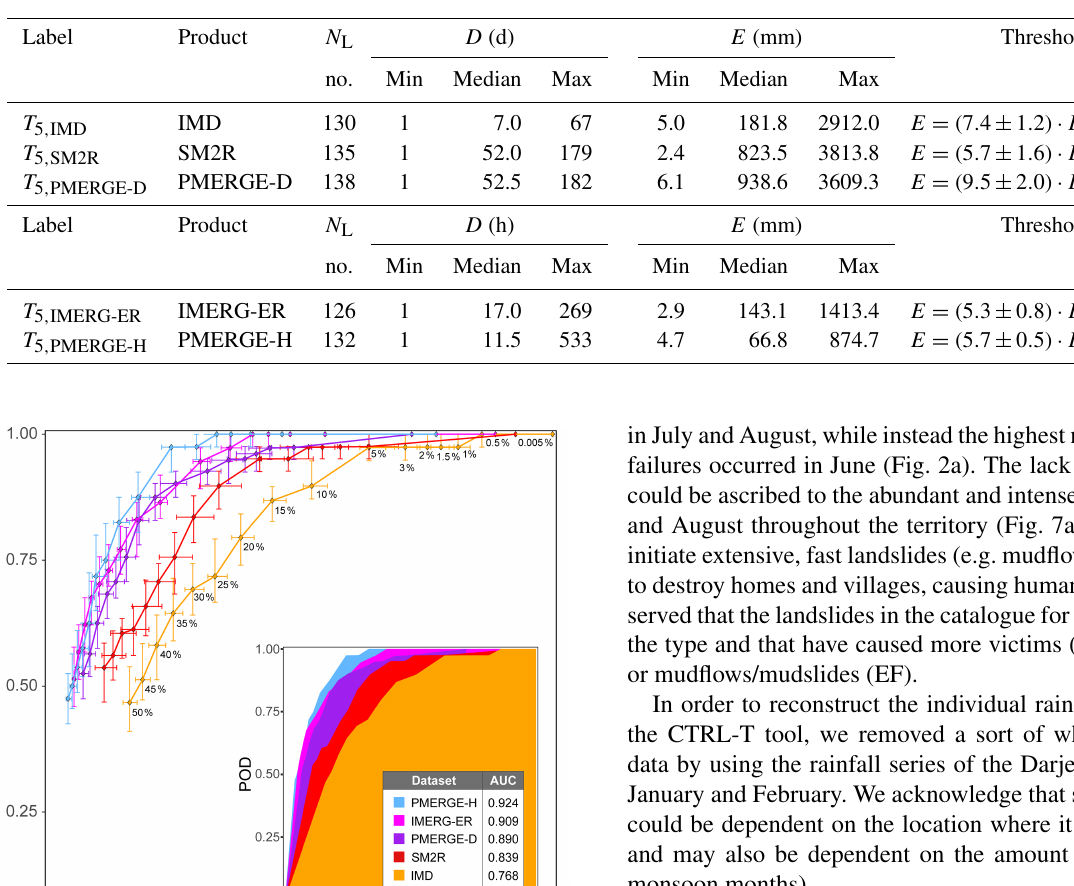
Table 1. ED thresholds for possible landslide occurrence in India. Label identifies the thresholds established in this work for the listed product. NL, number of landslides with reconstructed rainfall conditions. D and E , the rainfall duration (in days or hours) and cumulated event rainfall (in millimetres). The threshold column lists the equations for the 5% ED thresholds.